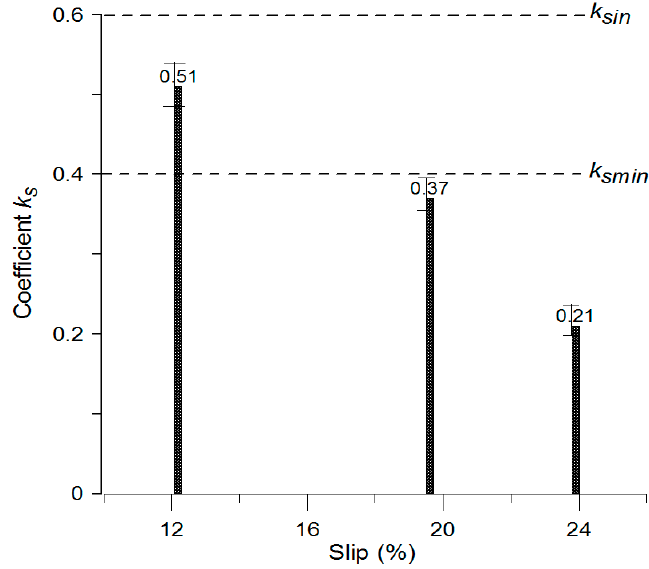
Figure 7. Influence of tractor wheels slip on the coefficient k s Simultaneously, when the tractor wheels slipped 19.6% (plowing depth 0.29 m), the soil structure coefficient decreased to 0.37. This meant that soil structure deteriorated and passed into the category of unsatisfactory.